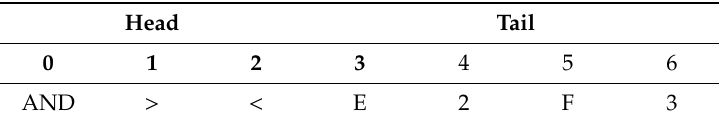
Table 2. The construction of a chromosome.